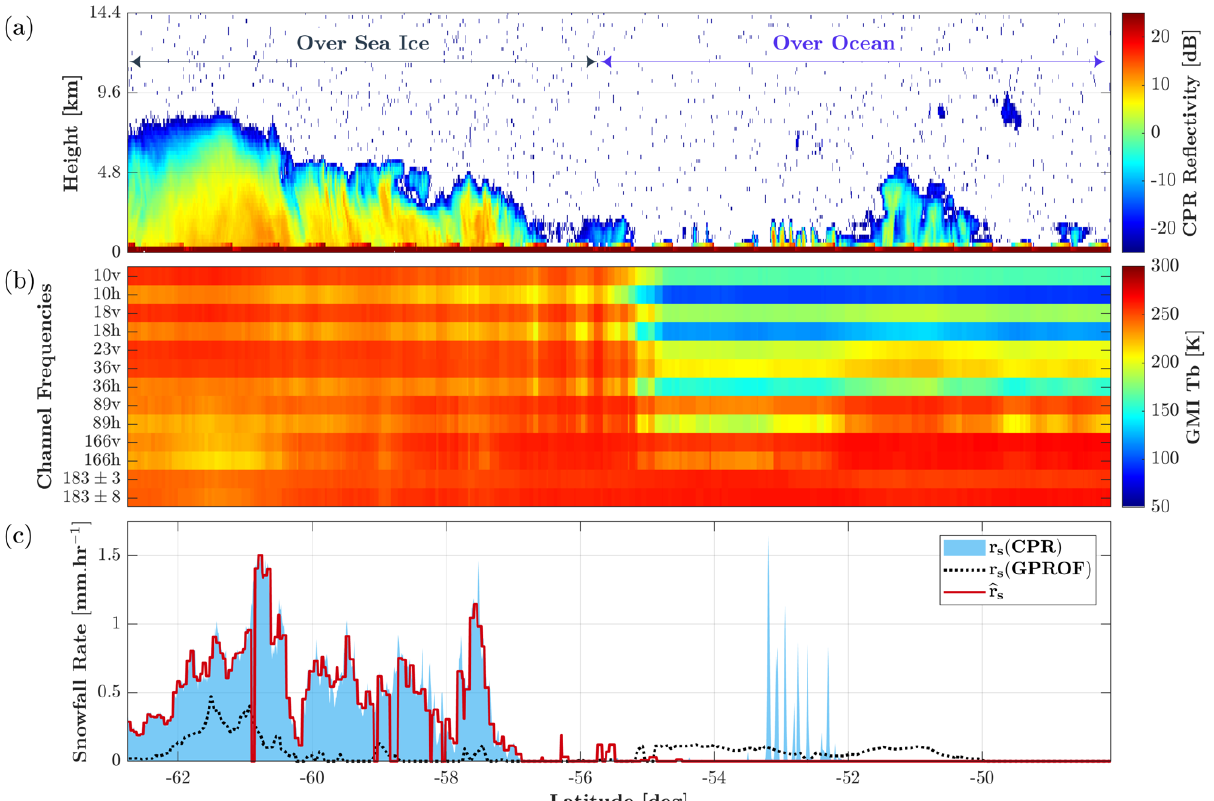
Figure 6. CloudSat-GPM coincidence on 10 October 2014 near 55S latitude, during GPM orbit 3498. ( a ) Coincidence of the CPR reflectivity in dBZ. ( b ) GMI brightness temperatures. ( c ) Snowfall rate retrievals along this CPR curtain from the 2 (blue shaded area) using the CloudSat + GPM products with a Bayesian algorithm ( Vahedizade et al., 2021) is shown by the red solid line. The official GPM product is represented with the black dotted line.